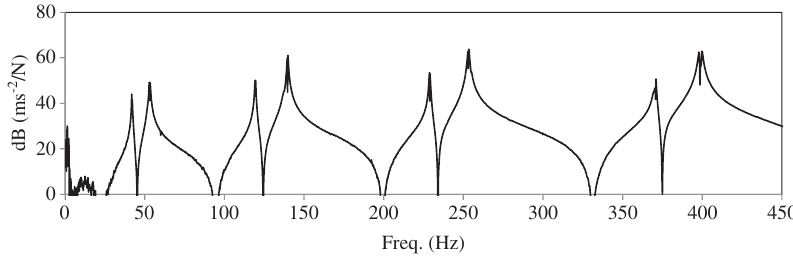
for truncated cone # 11